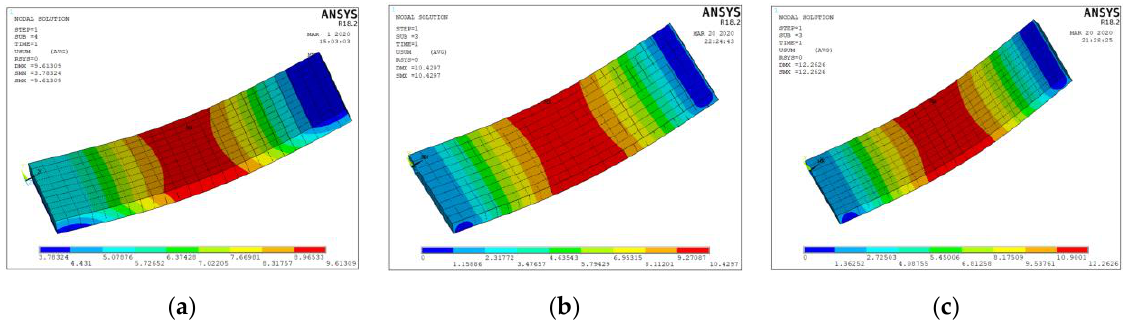
Figure 19. Deflection nephogram of composite floor with different thickness: ( a ) 120, ( b ) 110 and ( c )